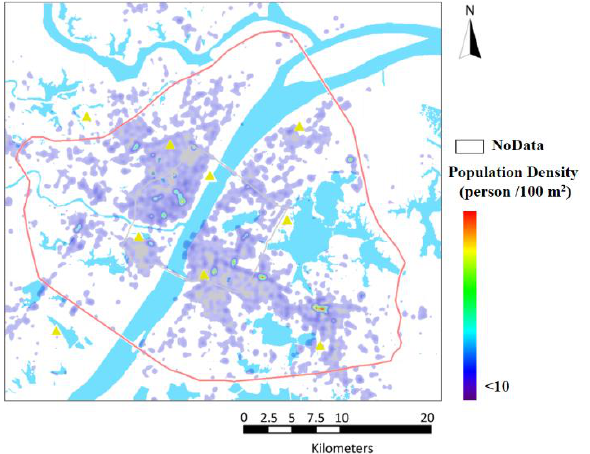
Figure 4. 24-hour average population density of Wuhan collected from Baidu Map on February 17 th 2017